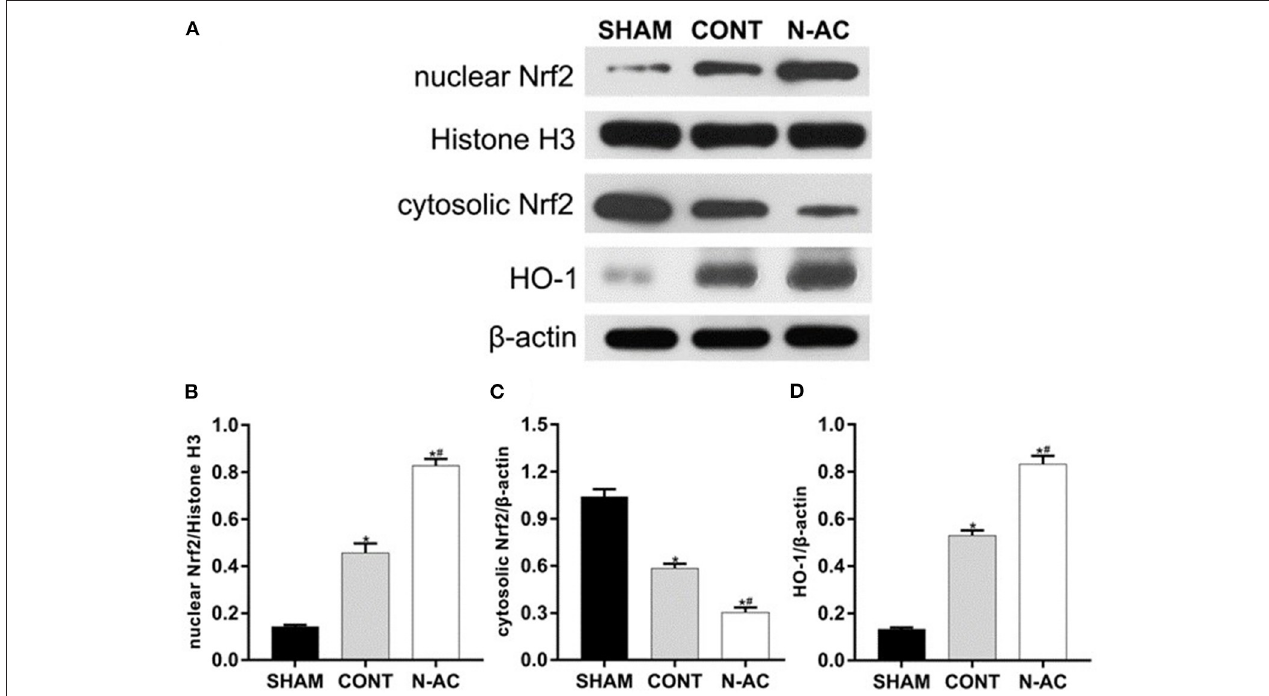
FIGURE 6 | N-AC enhances nuclear Nrf2 accumulation and upregulates the expression of HO-1 in the kidney at 6h after ROSC. (A) Representative images of nuclear Nrf2, cytosolic Nrf2, and HO-1 protein levels in each group at 6h after ROSC. (B) The densitometric analysis of nuclear Nrf2 expression relative to the loading control. (C) The densitometric analysis of cytosolic Nrf2 expression relative to the loading control. (D) The densitometric analysis of HO-1 expression relative to the loading control. SHAM, sham group; CONT, control group; N-AC, N-AC group. Sham group, n = 5; Control group, n = 7; N-AC group, n = 7. Data are expressed as mean ± SD. * P < 0.01, vs. sham group; # P < 0.01, vs. control group.